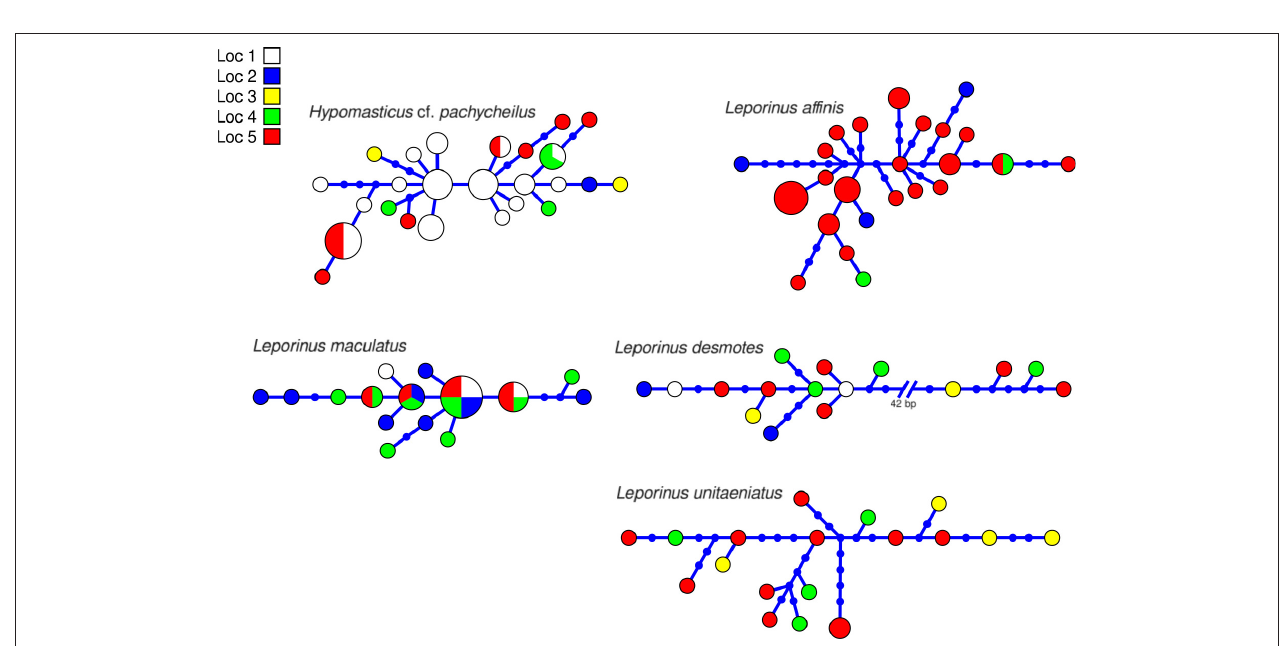
FIGURE 4 | Haplotype network of five species of Anostomidae indicating geographic occurance of the haplotypes. Networks were generated in HAPVIEW , and haplotype size is proportional among networks and to the number of individuals with that haplotype. Localities are: (1) Zé dos Gatos rapid; (2) São Miguel rapid; (3) Remanso dos Botos rapid; (4) Santa Isabel rapid; (5) São Bento rapid and Rebojo rapid.